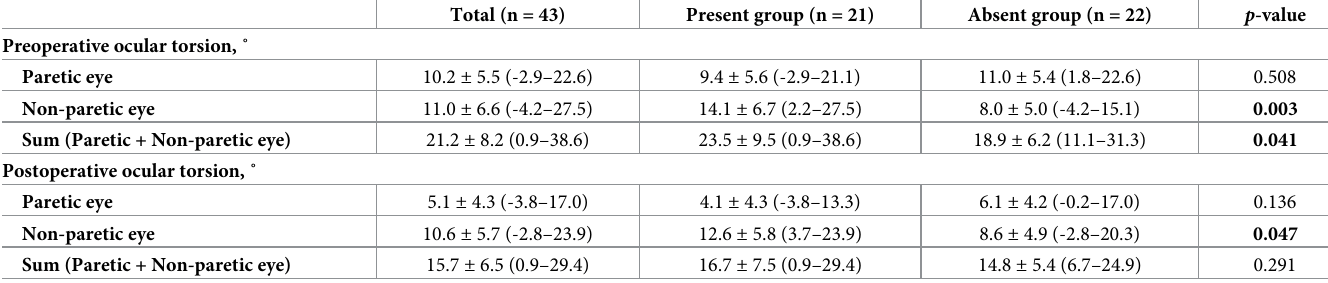
Table 2. Comparison of the disc-fovea angle according to the absence of the trochlear